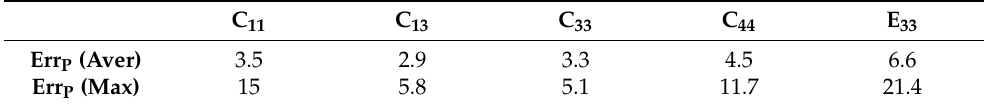
Table 3. Average evaluation of the results in the parameter space in ppm.